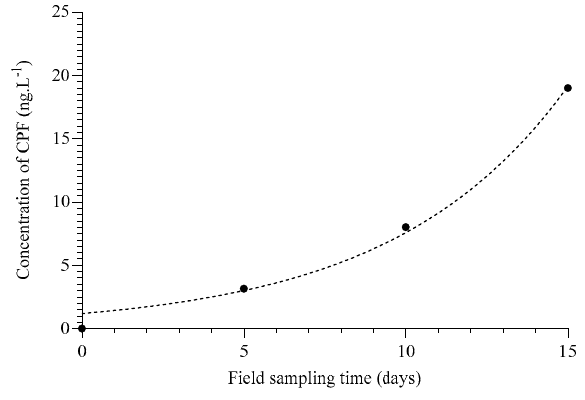
Figure 6. CPF SPMDs uptake process.